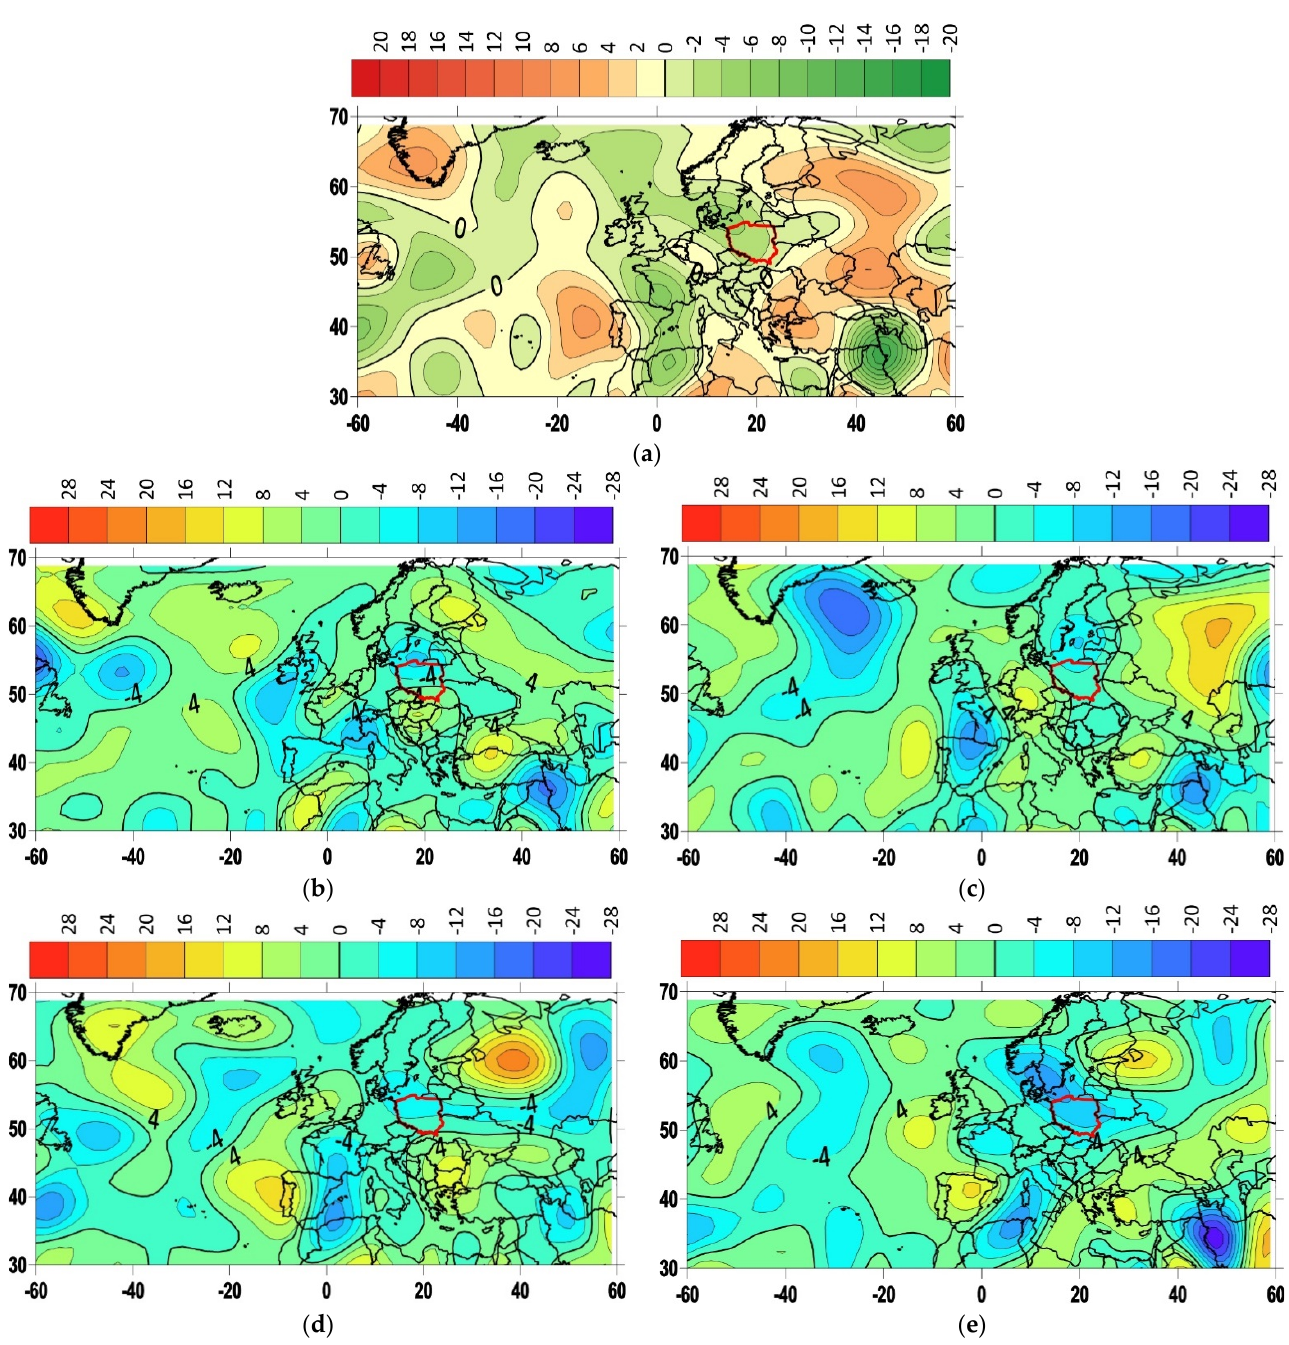
Figure 15. Vertical velocity in 10 − 2 Pa · s − 1 for 1963 heat wave: ( a ) average in the period 1–7.08; ( b ) on day before heat wave (31.07); ( c ) on 2.08; ( d ) on 6.08; ( e ) on day after heat wave (8.08). The red line marks the borders of Poland.